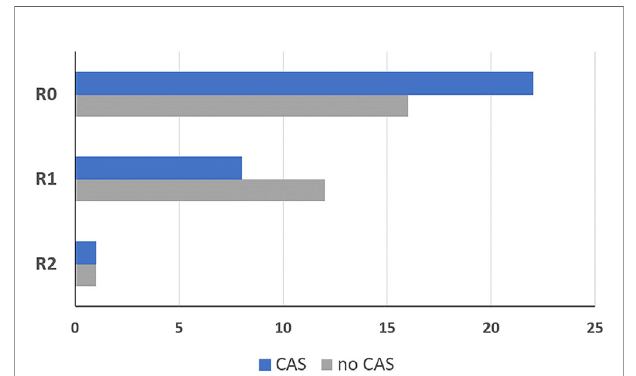
FIGURE 10 | Comparison of the pre- and postoperative intraorbital volumes after ablative surgery and primary reconstruction using CAS. The difference between the preoperative and postoperative volume is signi fi cant. * shows signi fi cance with a p-value